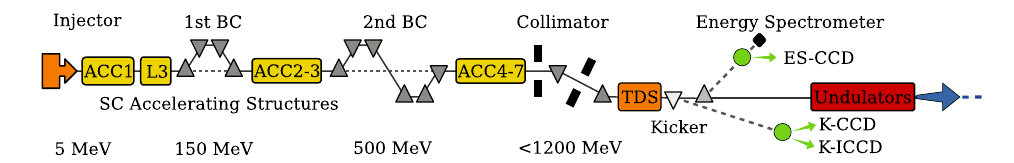
FIG. 1. Schematic layout of the Free-Electron Laser in Hamburg (FLASH) with its superconducting (SC) accelerating structures (ACC), the two magnetic bunch compressor (BC) chicanes, and the third-harmonic rf linearizer system (L3). The positions of the experimental setups and diagnostics used for the measurements presented in this paper are indicated by green